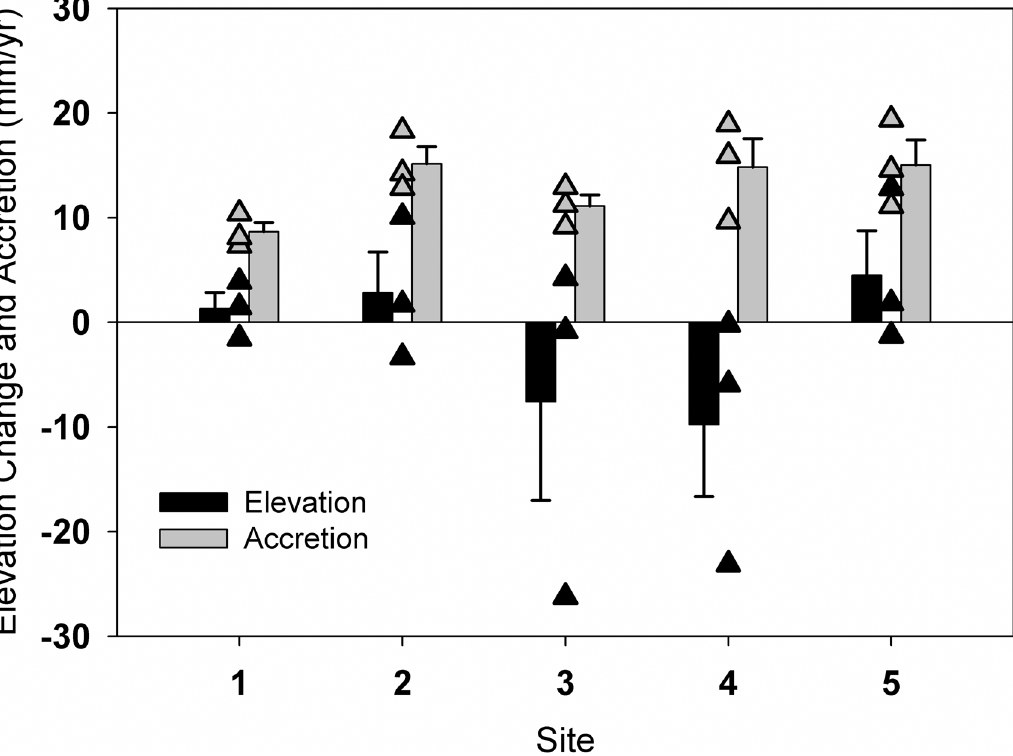
Fig 2. Elevation change (black bars and triangles) and surface accretion (gray bars and triangles) at 5 sites across the Nanticoke River subestuary of Chesapeake Bay. Site numbers 1 – 5 proceed from downstream brackish marshes to upstream tidal freshwater marshes. Bars represent mean +1 SE of elevation change or accretion rate across 3 replicate subsites, depicted individually as triangles. Rates reflect measurements made from October 2007 through October